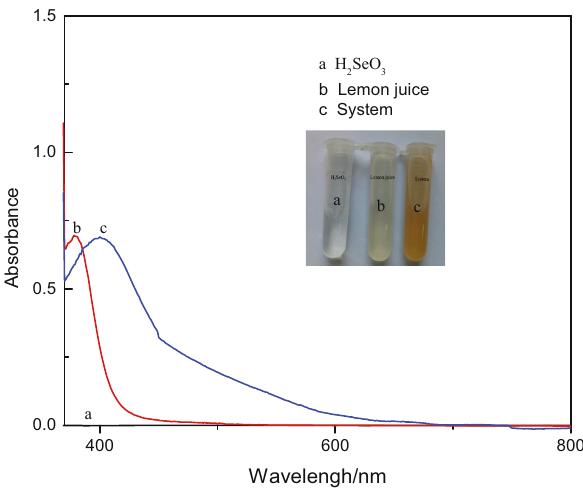
Figure 1: UV - Vis spectra of selenite, lemon juice, and selenite - lemon juice system.